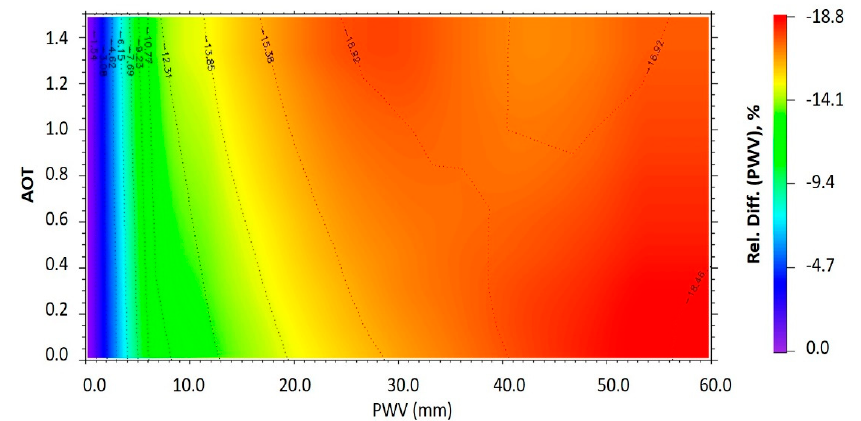
Figure 3. PWV effect (Rel.Dif (PWV), %) estimated by Obregón et al. [24] for each combination of AOT and PWV values.